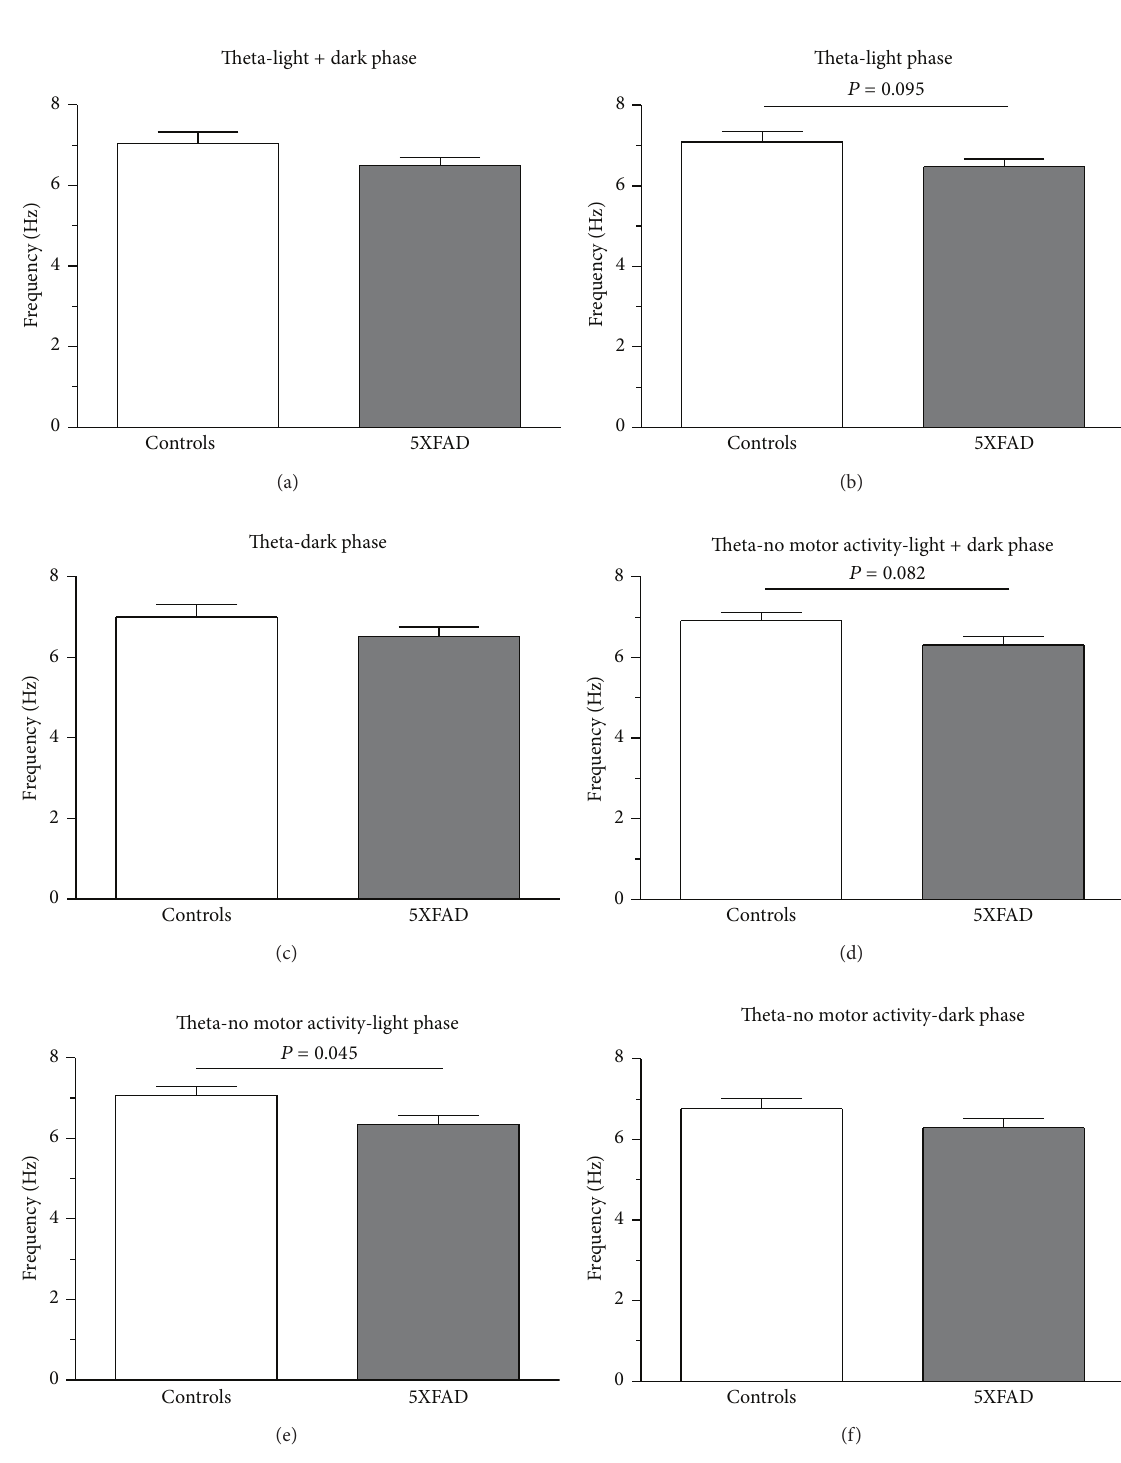
Figure 8: Theta frequency in controls and 5XFAD mice. The mean theta frequency was calculated for the total observation period (48 h, (a)–(c)), no motor activity ((d)–(f)), and motor activity (not shown). In all cases, theta frequency is reduced. Again, this reduction turned out to be significant during no motor activity